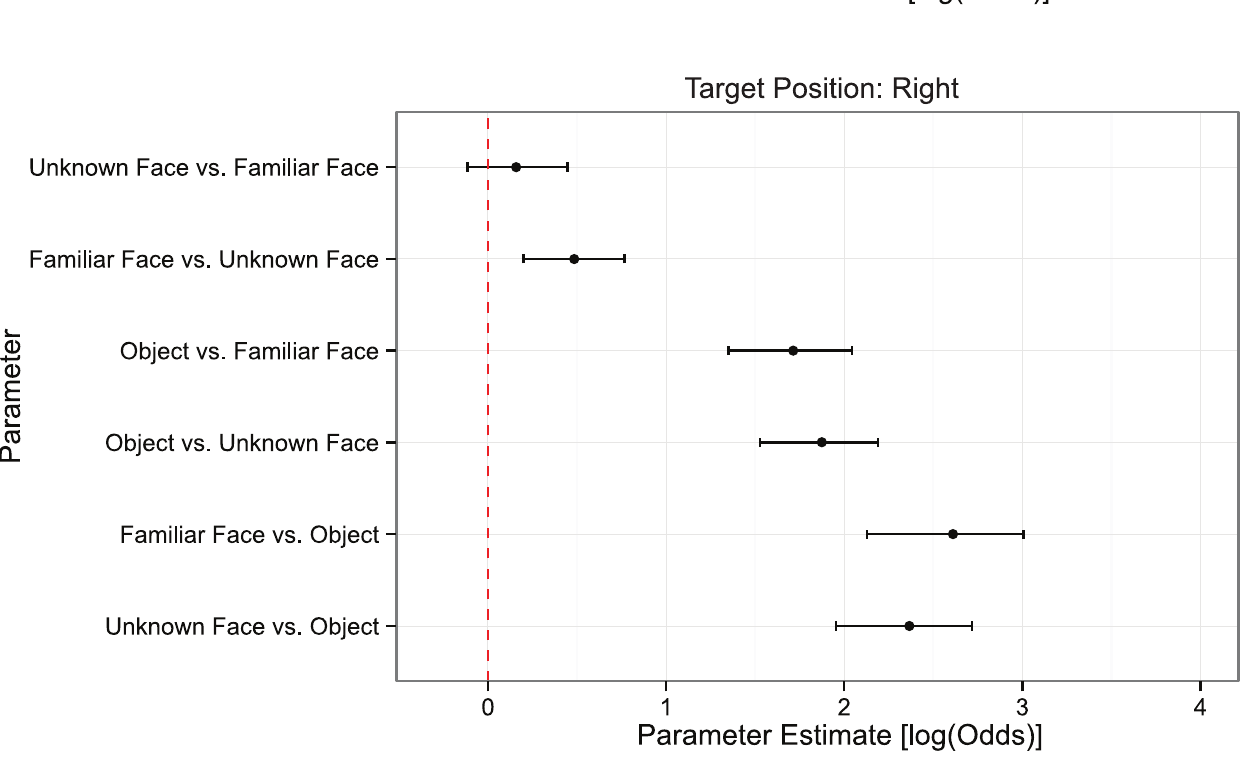
Fig 3. Parameter estimates for Task in the Logit Mixed-Effects Models obtained by changing reference level for target position. Error bars represent 95% bootstrapped confidence intervals.